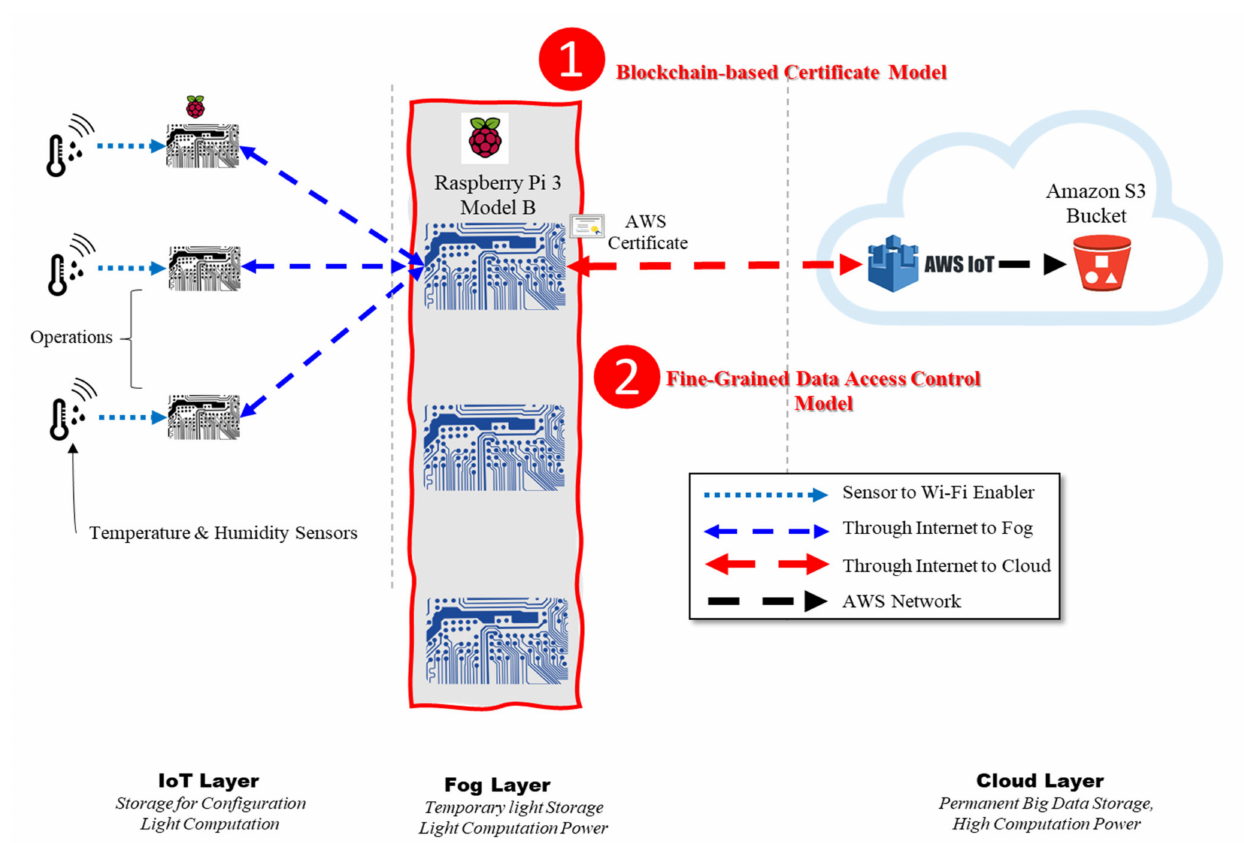
Figure 1. Overview of the IoT–Fog–Cloud